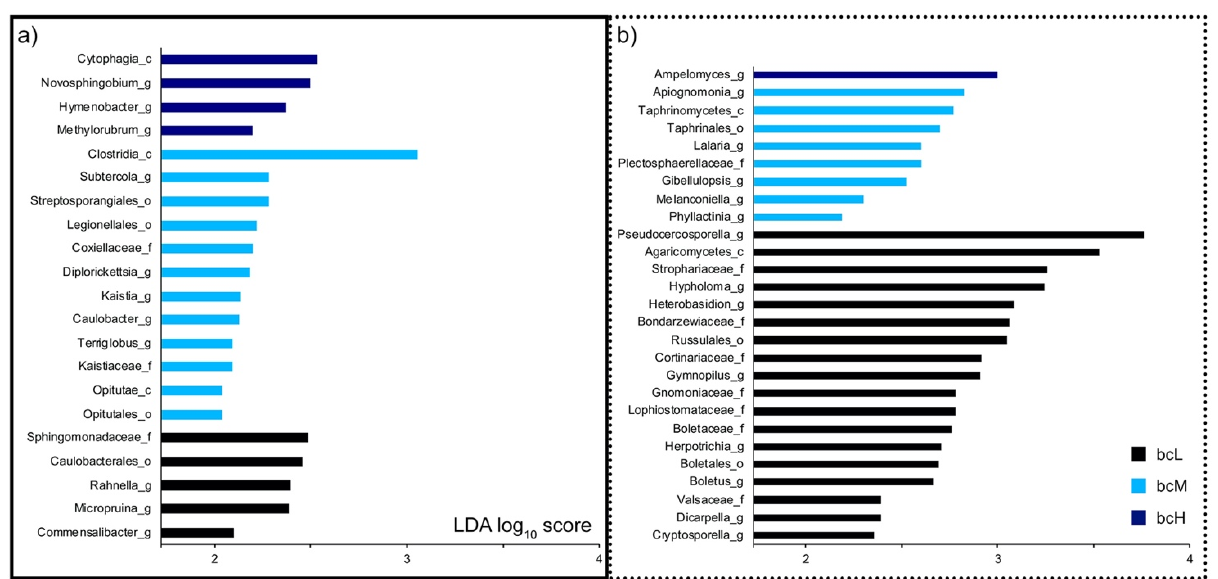
Figure 3. Indicators of bacterial and fungal leaf communities with different phylloplane black carbon load. Significant ( p < 0.05, LDA with effect size) differentially abundant bacterial ( a ) and fungal ( b ) taxa between communities with low (bcL), medium (bcM), and high (bcH) phylloplane BC load. Only LDA log 10 scores ≥ 2 were considered; a higher score denotes a more differentially abundant taxon. After every taxon name, the rank is indicated (c: class, o: order, f: family, g: genus).